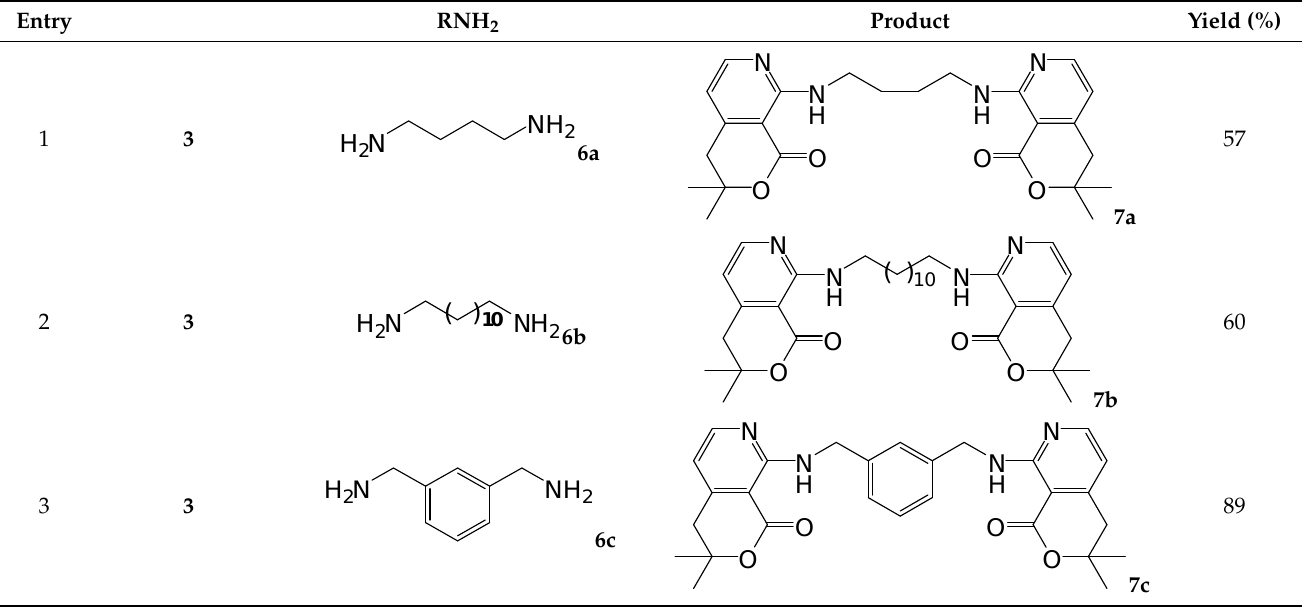
Figure 4. Synthesis of new bis-(2-aminopyridines) 7a – c.